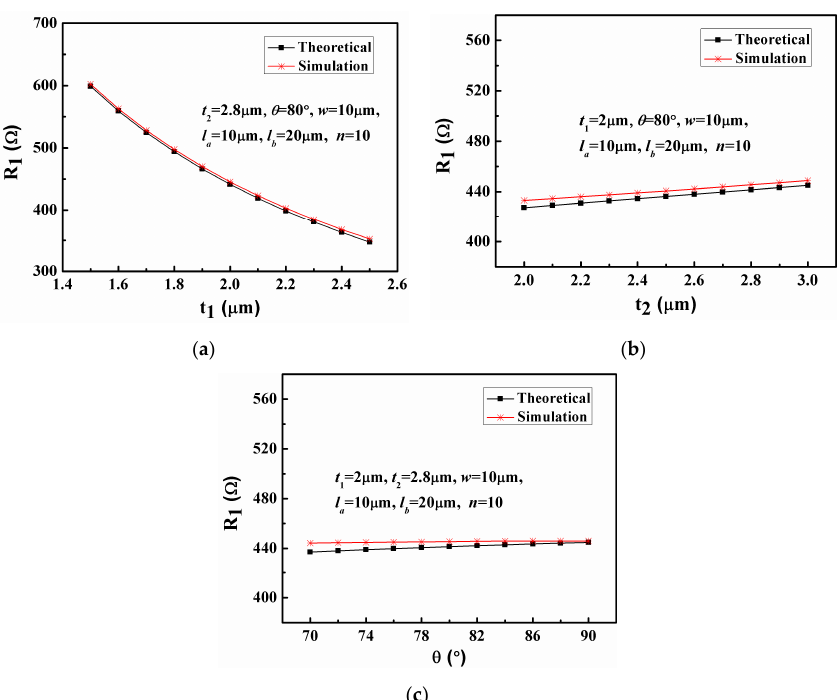
Figure 6. Theoretical and simulation results of the relationship between R 1 and the geometrical parameters: ( a ) The thickness of the polysilicon layer ( t 1 ); ( b ) The thickness of the PSG layer ( t 2 ); ( c ) The sidewall etch angle of the PSG layer ( θ ). Appl. Sci. 2018 , 8 , x FOR PEER REVIEW